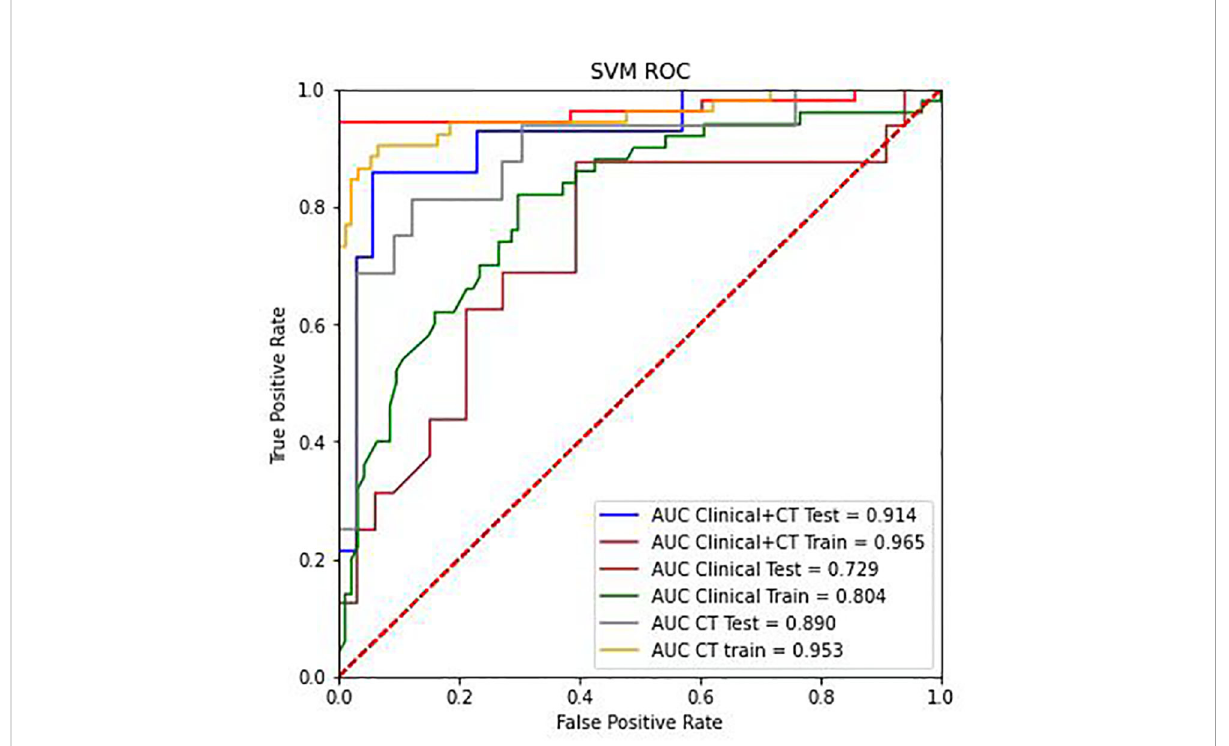
FIGURE 7 The ROC curve analysis of the CT radiomics models, clinical features, and combinations of CT radiomics and clinical features in the training group and testing